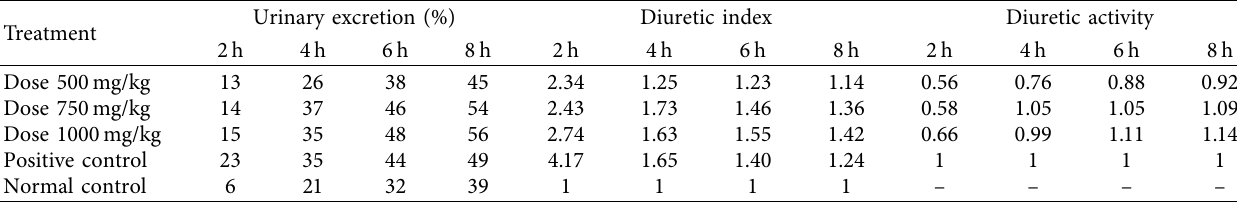
Table 5: Diuretic activity of the rat treated by the microencapsulated bioactive product. Treatment